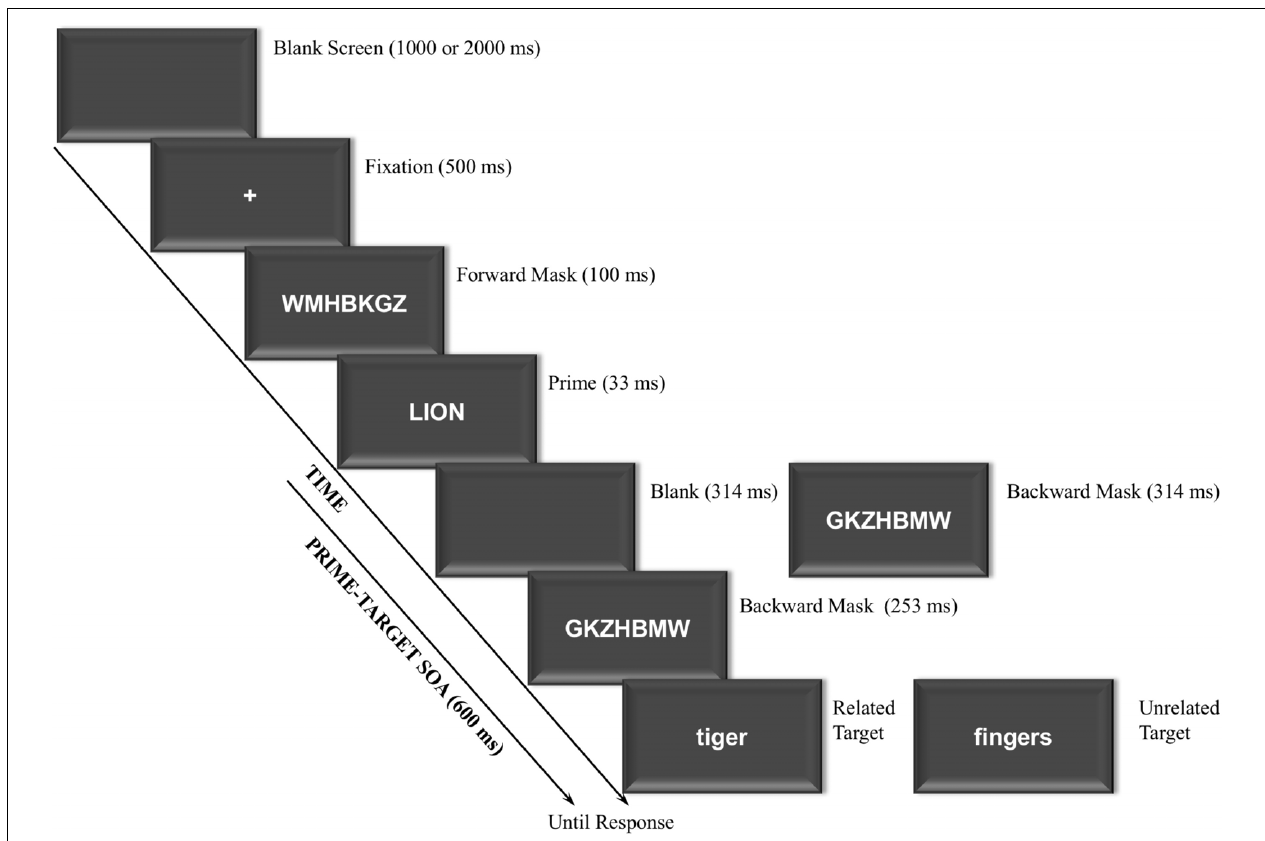
FIGURE 1 | Sequence and time of events in experiment. The word stimuli shown here for related and unrelated trials have been translated from Spanish to